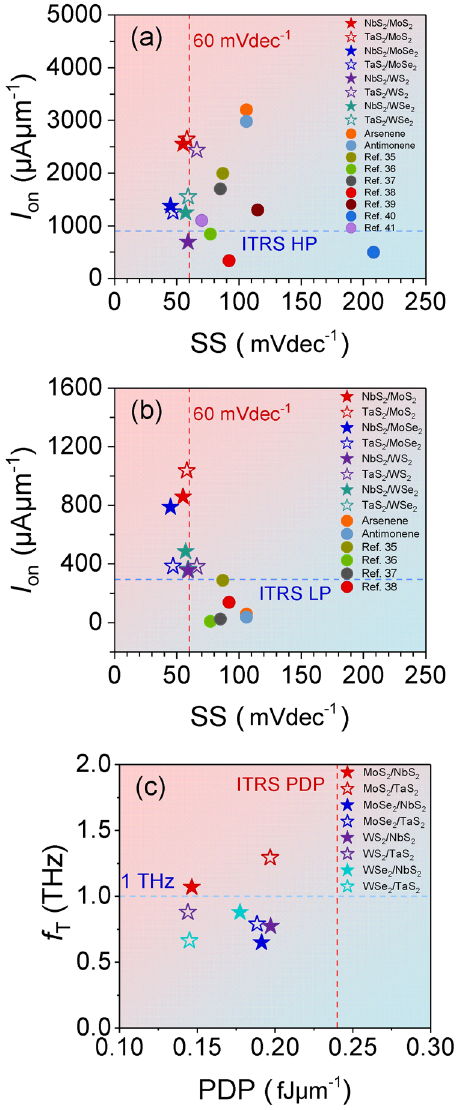
Fig. 3 Benchmark of I on and SS of top contact CM-FETs. a HP goal and ( b ) LP goal of MOSFETs, respectively. The other data are extracted from the arsenene 34 , antimonene 34 , BP 35 , Te 36 , GeSe 37 , silicane 38 , AsP 39 , Si nanowire (NW) 40 and carbon nanotube (CNT) 41 . c The f T and PDP of CM-FETs compare with ITRS goals. The I on of ITRS HP and LP is set to 900 μ A μ m − 1 and 295 μ A μ m − 1 , respectively. The ITRS PDP is set as 0.24 fJ μ m − 1 .